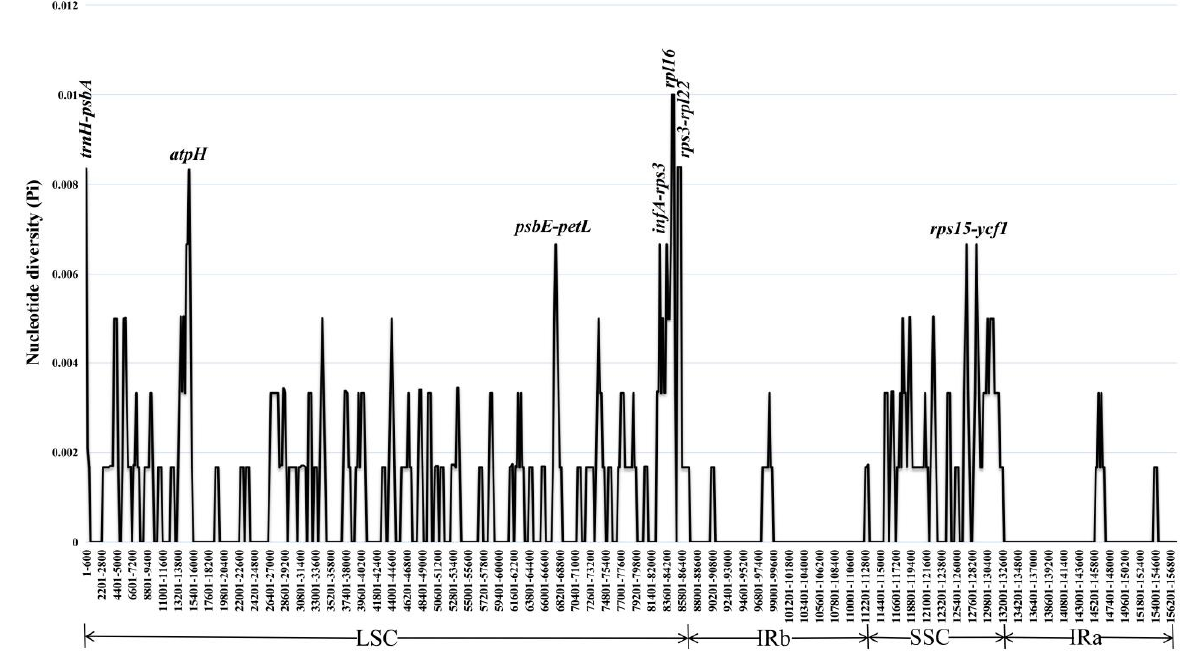
Figure 8. Nucleotide diversity of the chloroplast genomes of two Clethra species.